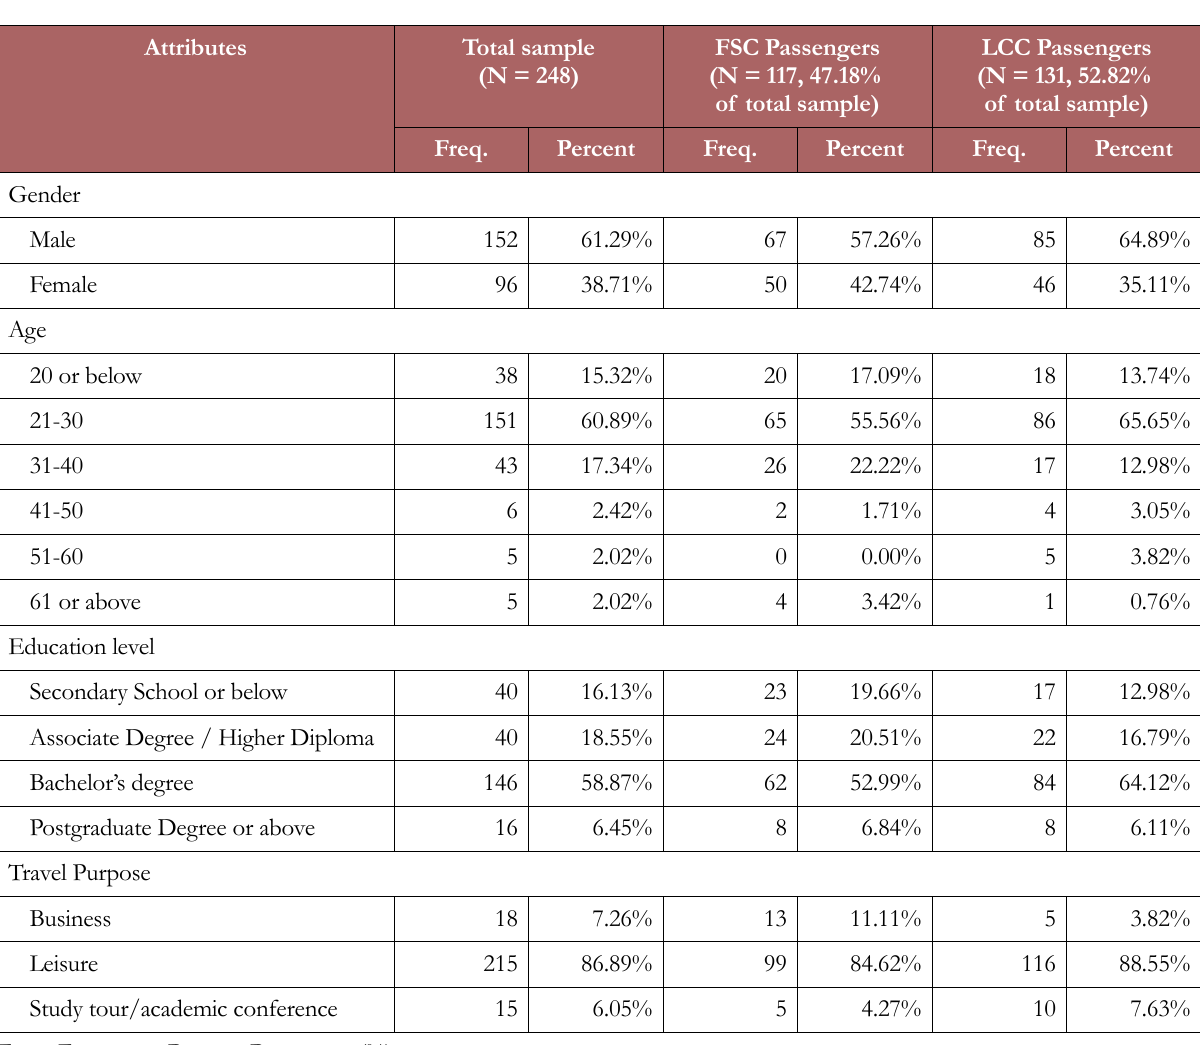
Table 1. Respondents’ characteristics